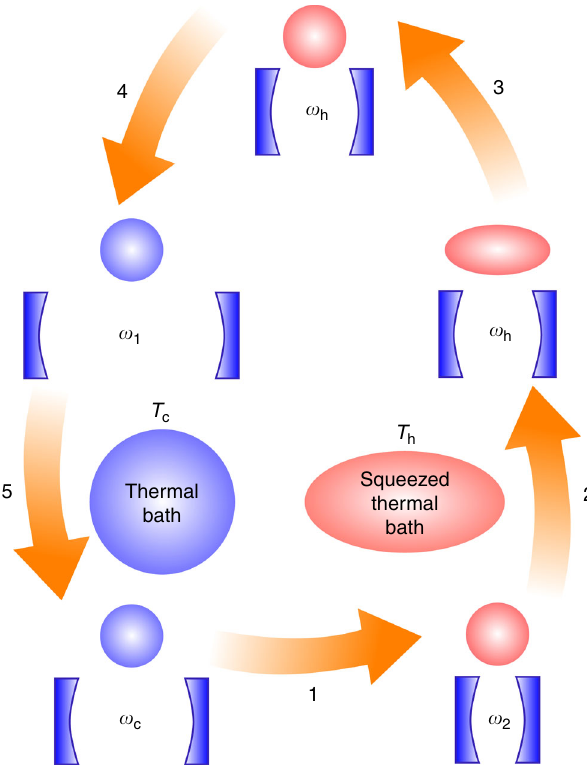
Fig. 5 A photonic Carnot cycle for a squeezed thermal bath. The cycle starts with a thermal state with frequency ω c and temperature T c (lower left corner). In stroke 1, the mode undergoes an adiabatic compression to frequency ω 2 = ω c T h / T c and temperature T h > T c . Thereafter, in the energising stroke 2, the frequency is slowly reduced to ω h ≤ ω 2 while the mode is connected to the squeezed thermal bath, yielding a squeezed thermal steady state. Its ergotropy is extracted in stroke 3 by an ‘ unsqueezing ’ unitary operation, resulting in a thermal state with temperature T h . In stroke 4, the frequency is again adiabatically reduced to ω = ω T T 1 h c / h such that the mode attains the temperature 5 is an isothermal compression back to the initial state